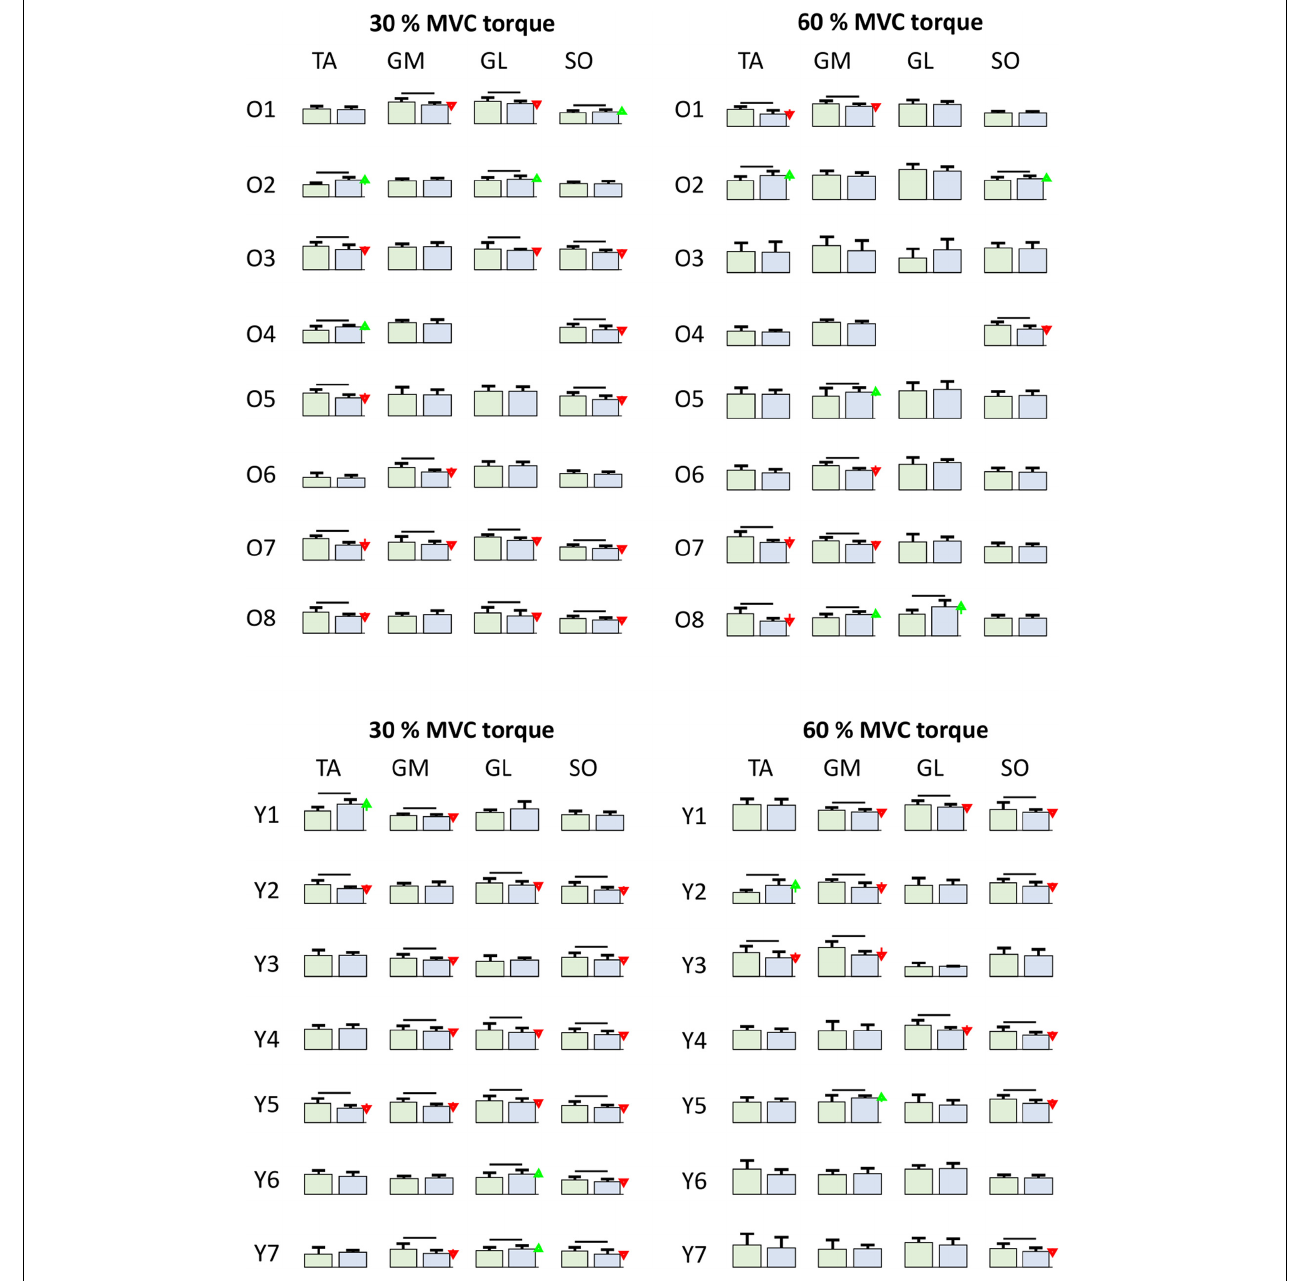
FIGURE 8 | Comparison of smoothed motor unit discharge rates (SDR, Mean ± SD) in individual older (Oi rows, top) and young (Yi rows, bottom) participants for different muscles (columns) at 30 and 60% MVC torque between BEFORE (left green bars) and AFTER (right blue bars). The red and green arrows indicate significant decrease and increase of SDR, respectively, at AFTER when compared to BEFORE (one-way ANOVA test, p < 0.05). TA, Tibialis anterior; GM, Gastrocnemius medialis; GL, Gastrocnemius lateralis; SO,